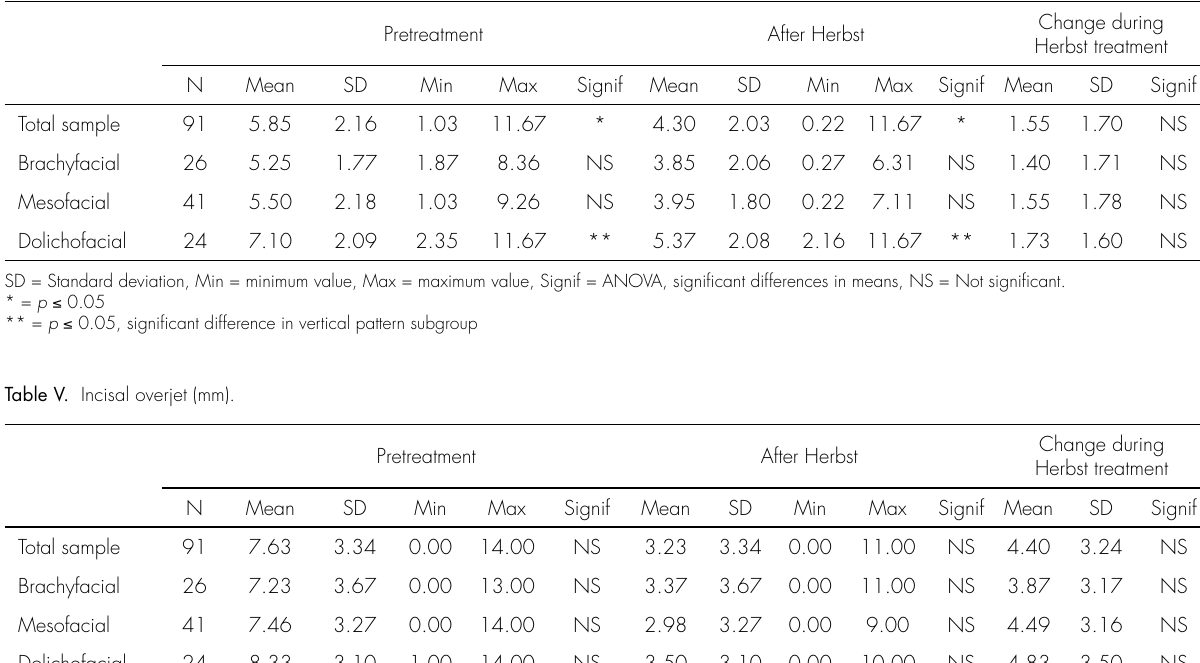
Table IV. ANB angle (degrees).